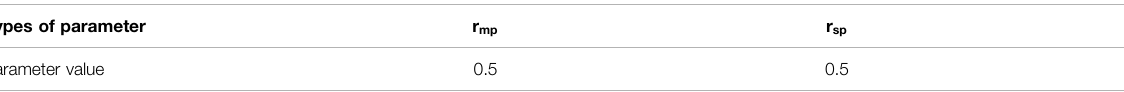
TABLE 2 | Parameters setting of the feature selection process.